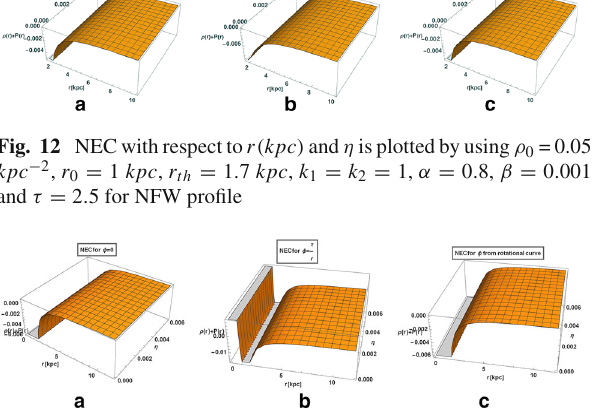
Fig. 13 NEC with respect to r ( kpc ) and η is plotted by using ρ 0 = 0.05 kpc − 2 , r 0 = 1 kpc , r th = 1 . 7 kpc , k 1 = k 2 = 1, α = 0 . 8, β = 0 . 001 and τ = 2 . 5 for URC